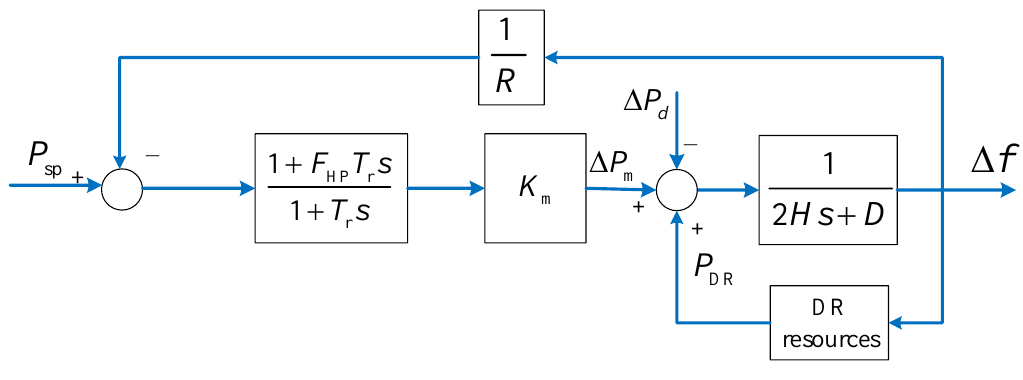
Figure 6. The simplified frequency response model.